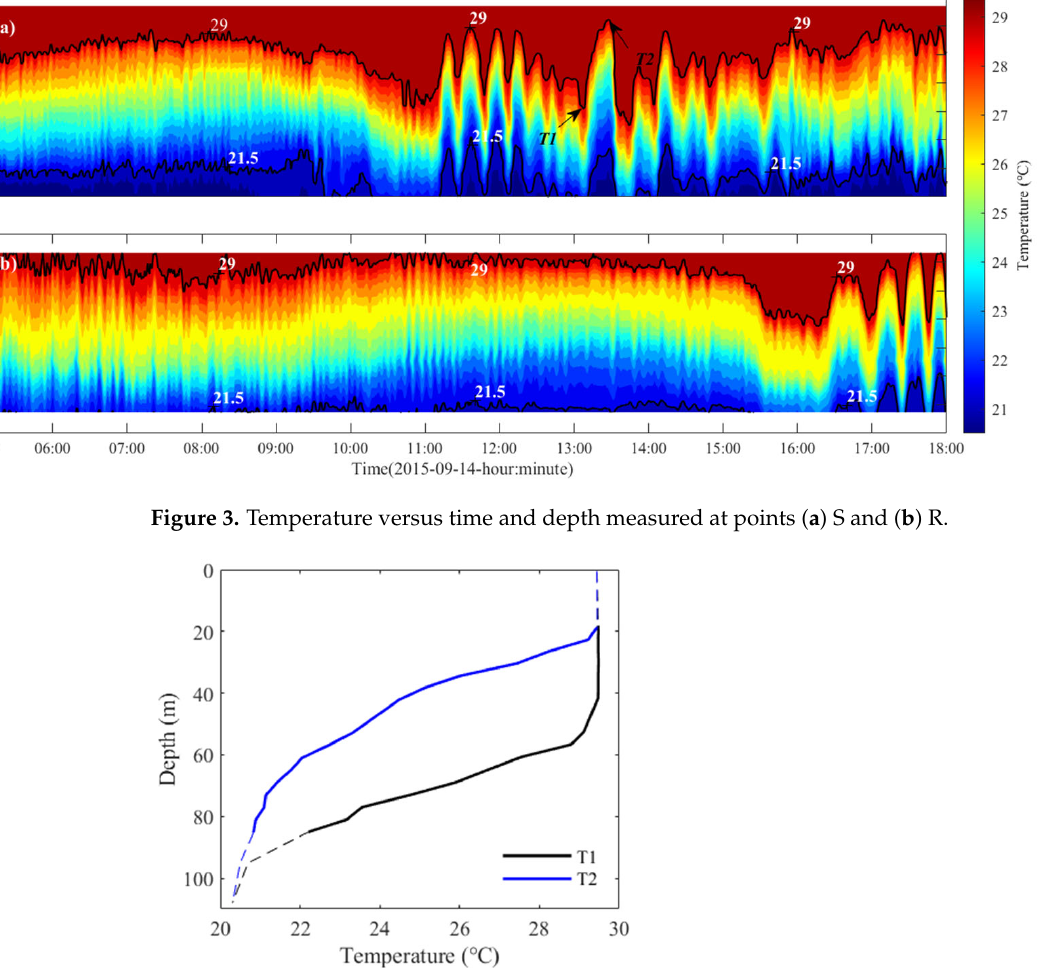
6 of 19 Figure 2. Temperature versus time measured at points S (black), R (red), and H (blue).